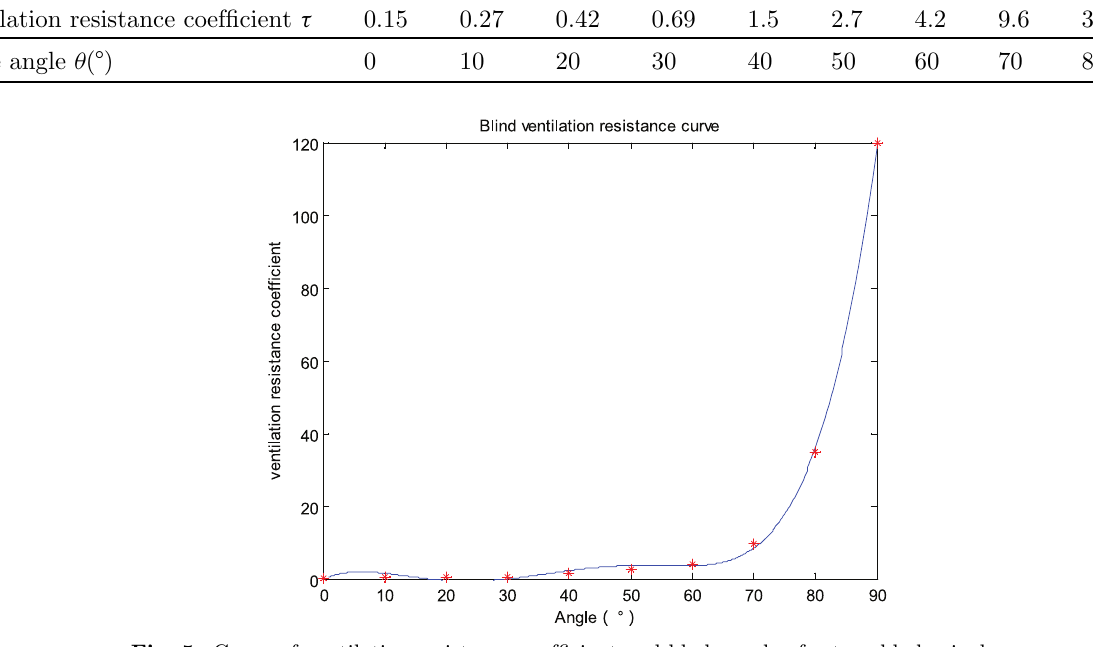
Fig. 5. Curve of ventilation resistance coef fi cient and blade angle of rotary blade air